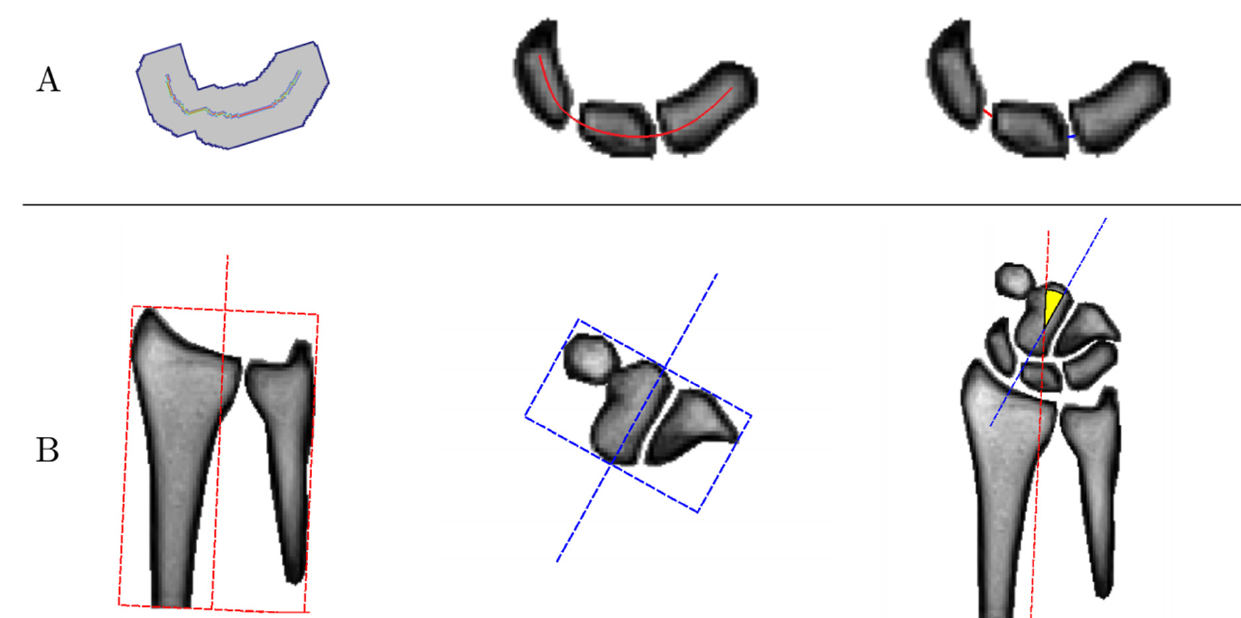
Figure 4. Graphical visualization of the algorithm-based measurements of carpal configuration. ( A ) Determination of scapholunate (SL) and lunotriquetral (LT) gap widths. First, the bone masks of the scaphoid, lunate, and triquetrum were connected (left). Then, the centerline of the three bones was determined along the carpal arcs (center). Eventually, the SL (red) and LT (blue) gap widths were determined based on the intersections of this centerline and the bone contours. ( B ) Determination of the wrist angle. The minimum bounding boxes around the bone contours of the forearm, i.e., radius and ulna (red, left), as well as around the distal row of the carpal bones (blue, center) were determined. Then, the wrist angle was calculated as the angle between the centers of the two boxes (yellow, right).